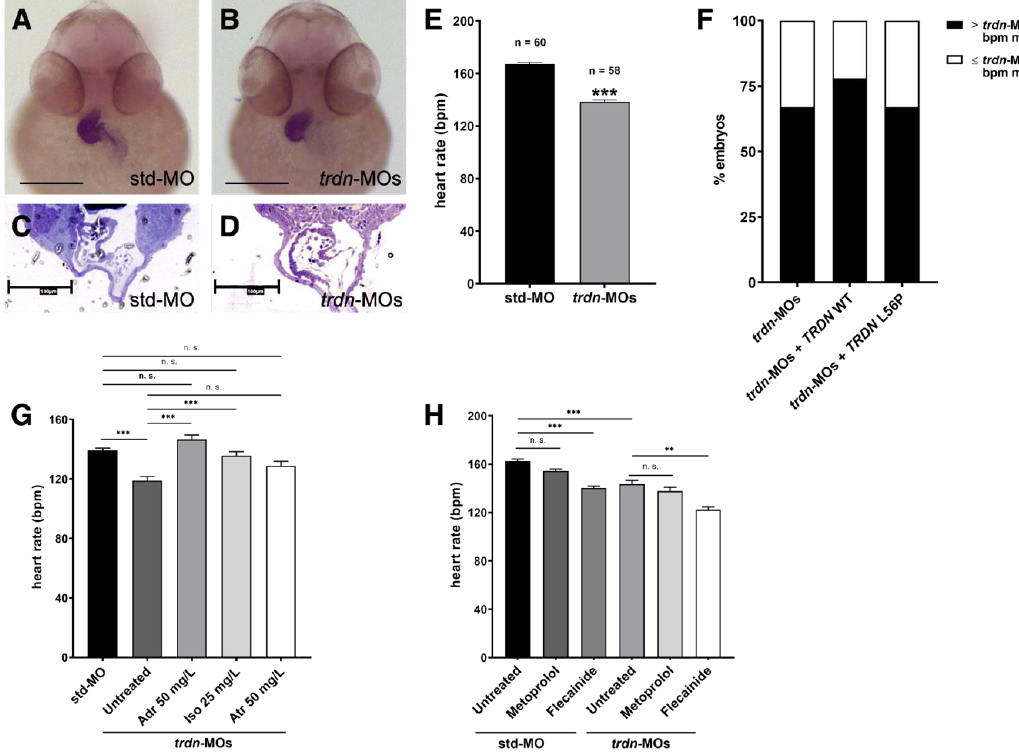
Figure 4. Heart morphology and function evaluation. ( A , B ) Frontal view of 48 hpf std-MO and trdn -MOs embryos hybridized with cmlc2 probe using WISH technique. Scale bars indicate 100 µ m. ( C , D ) Semithin section of std-MO and trdn -MOs embryos in the heart region. Scale bars indicate 100 µ m. ( E ) Quantification of heartrate in embryos at 48 hpf injected with std-MO and trdn -MOs. ( F ) Percentage of embryos with a heartbeat superior to the mean of the heartbeat (bpm) of trdn -MOs. ( G ) Heartbeat count in 3 dpf std-MO and trdn -MOs untreated or adrenaline-, isoprenaline- and atropine-treated embryos. ( H ) Heartbeat count in 3 dpf std-MO and trdn -MOs untreated or treated with metoprolol or flecainide. ( F – H ) At least 30 embryos were analyzed for each group. Values are expressed as mean ± SEM. *** p < 0.001, ** p < 0.01, n.s. = not significant, Mann–Whitney test ( E ) and one-way ANOVA followed by Tukey post-hoc correction ( G , H ). Adr, adrenaline; Iso, isoprenaline; Atr,